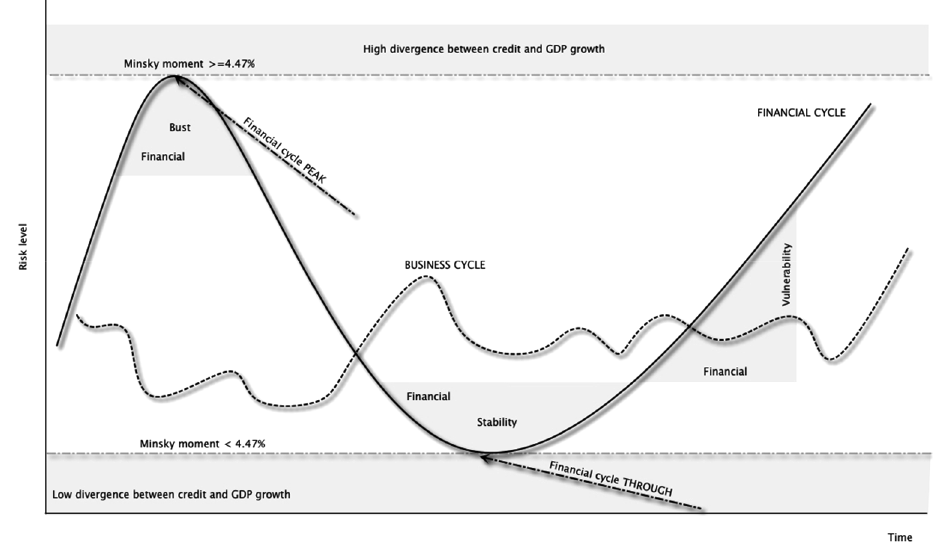
Figure 6. Financial and business cycles under Minsky moment (source: authors’